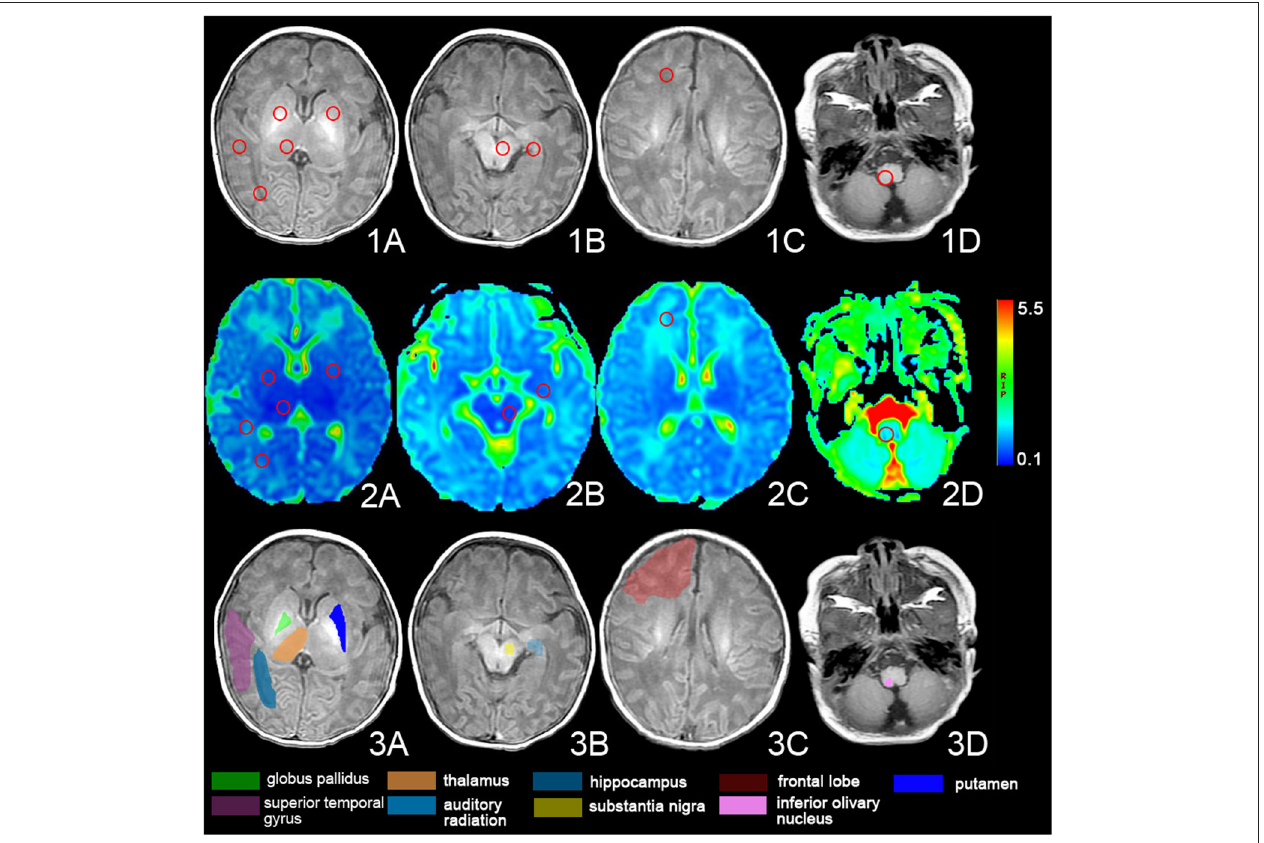
FIGURE 1 | The regions of interest (ROIs) of the DKI. Images show the ROIs of T1-weighted images (1. A–D) and DKI images (2. A–D) and the anatomy of the ROIs (3. A–D). The ROI was set in bilateral globus pallidus, dorsal thalamus, frontal lobe, auditory radiation, superior temporal gyrus, substantia nigra, hippocampus, putamen, and inferior olivary